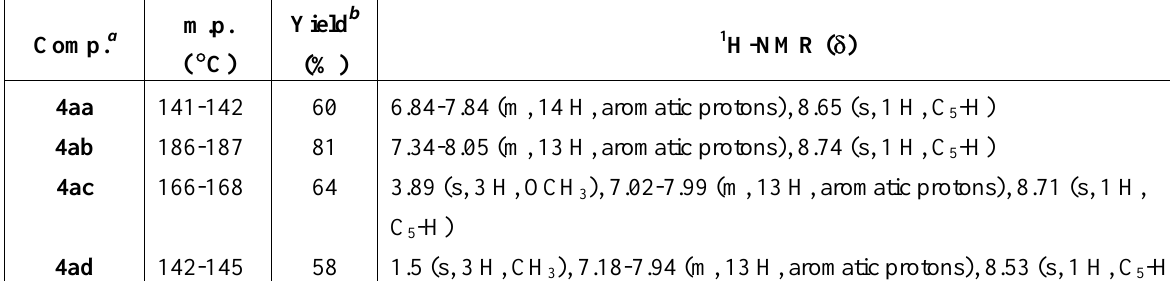
Table 1. Physical and 1 H-NMR data